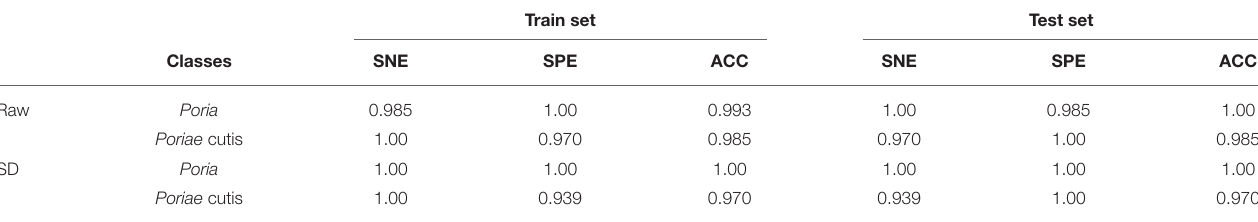
TABLE 2 | The classification parameters of PLS-DA established by raw and SD FT-NIR